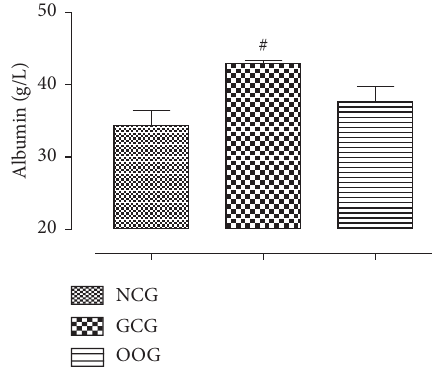
Figure 3: The concentration of plasma albumin in the treated animals. # P < 0 . 05, compared to the NCG.